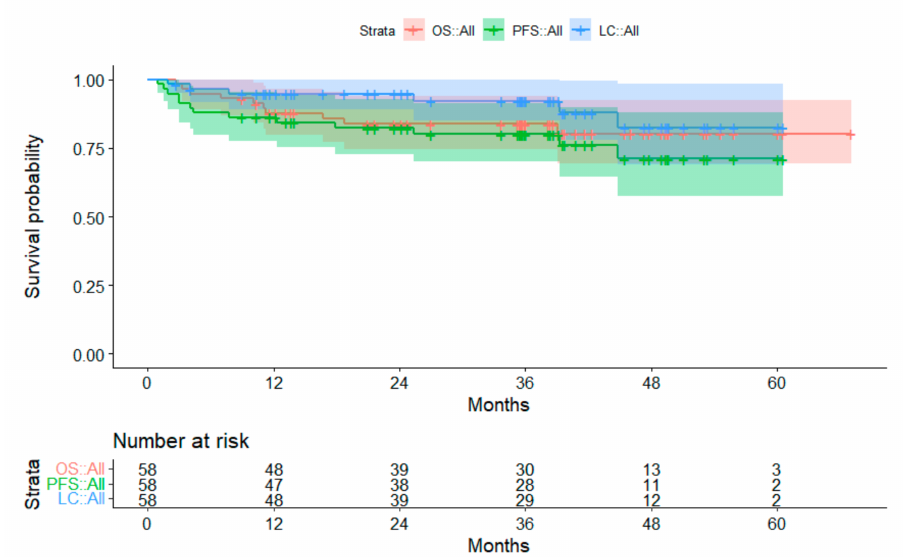
Figure 3. Survival curves for patients with medulloblastoma. The 95% confidence intervals are displayed. Abbreviations: OS = overall survival; PFS = progression-free survival; LC = local control.